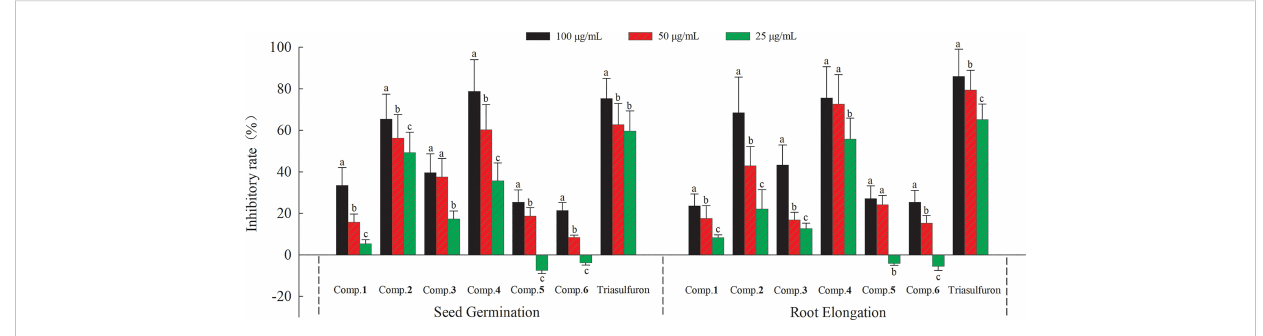
FIGURE 5 Phytotoxic effects of compounds 1 − 6 on the seed germination and root elongation of A. thaliana . Different letters indicate signi fi cant differences between concentration treatments ( p < 0.05).